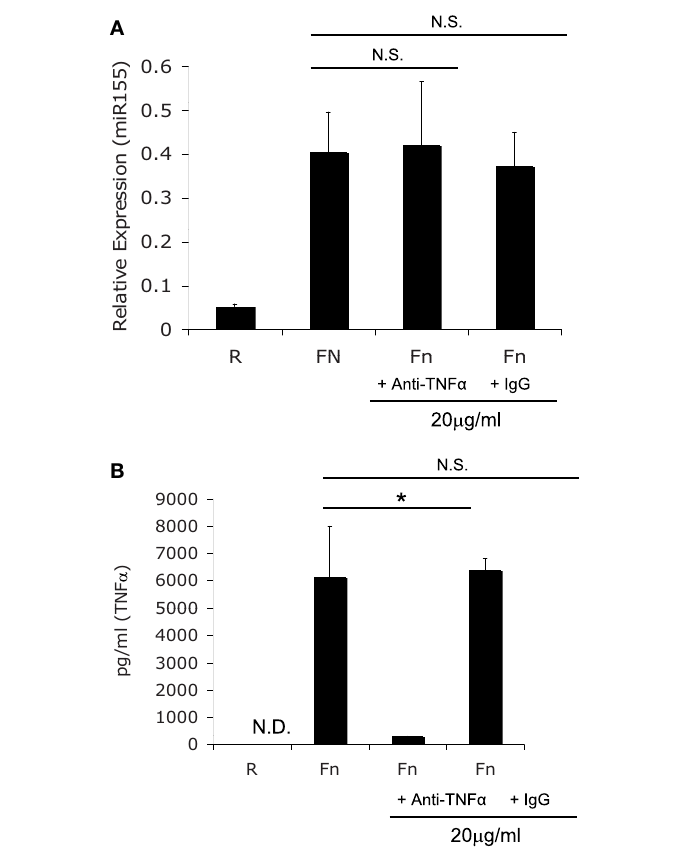
37˚C for 1h. New PBM were then cultured in the conditioned media conditions, uninfected (R), or direct infection (FN) for 6h. RNA was collected and miR-155 expression was assayed by qRT-PCR. (D) Effective neutralization of IFN β was demonstrated by pre-treating media with recombinant IFN β (500U/ml) with or without neutralizing antibody or isotype control antibody. Then PBM were cultured in media alone, IFN β , IFN β plus neutralizing antibody, or IFN β plus isotype control for 15min. Cells were lysed and subject to western blot for phosphorylated STAT1, followed by Actin